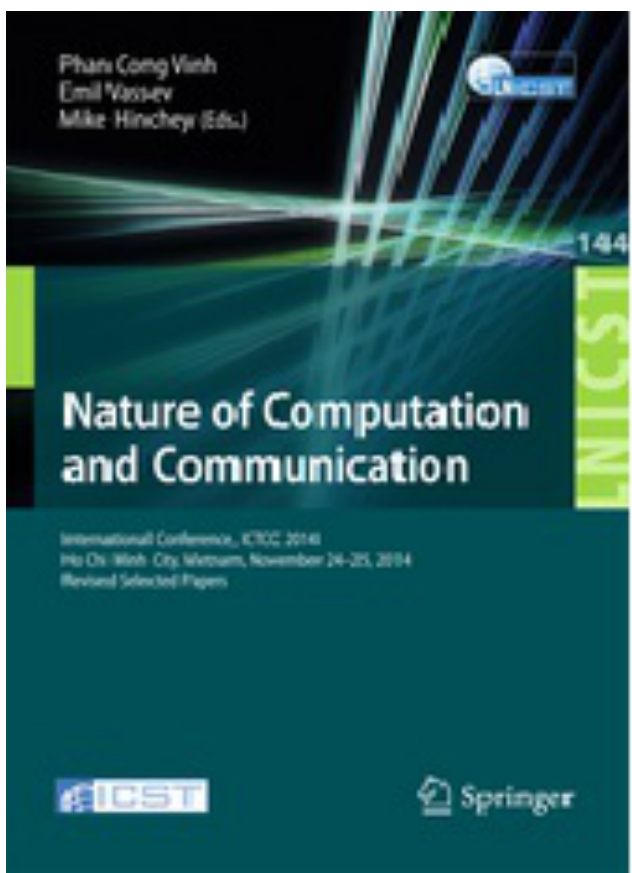
Figure 1. Cover of the